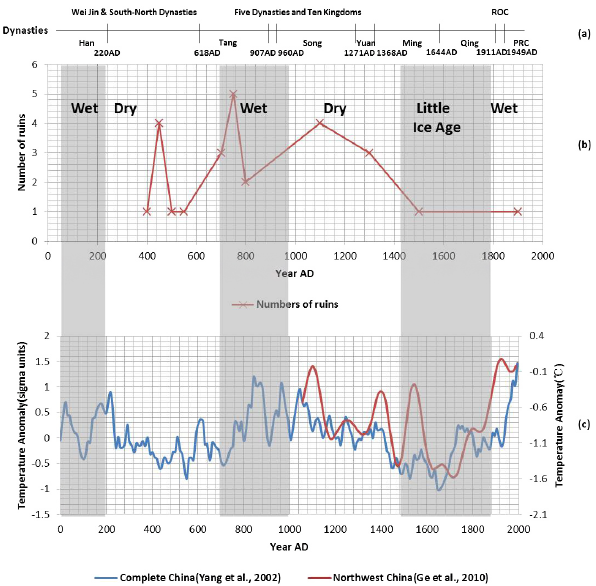
Fig. 5. Climate change and abandonment of human settlements dur- ing the past 2000years within the Tarim River basin: (a) main im- perial dynasties in China’s history; (b) number of ruins, indicating the abandonment of human settlements; (c) temperature variation. Note that the whole period was divided into wet and dry sub-periods according to the reconstructed record of precipitation (Yang et al., 2002; Ge et al., 2010), of which the wet period is illustrated in grey.